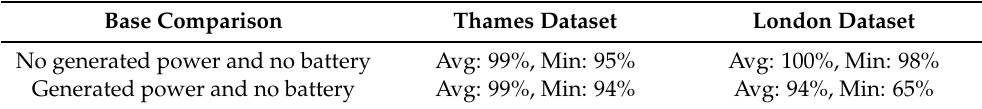
Table 5. Relative performance of the smart algorithm with converging and diverging generation and demand uncertainty compared to perfect forecasts in the simulated Thames or London environment. The underlying basis for comparison is no battery and/or generated power (Table